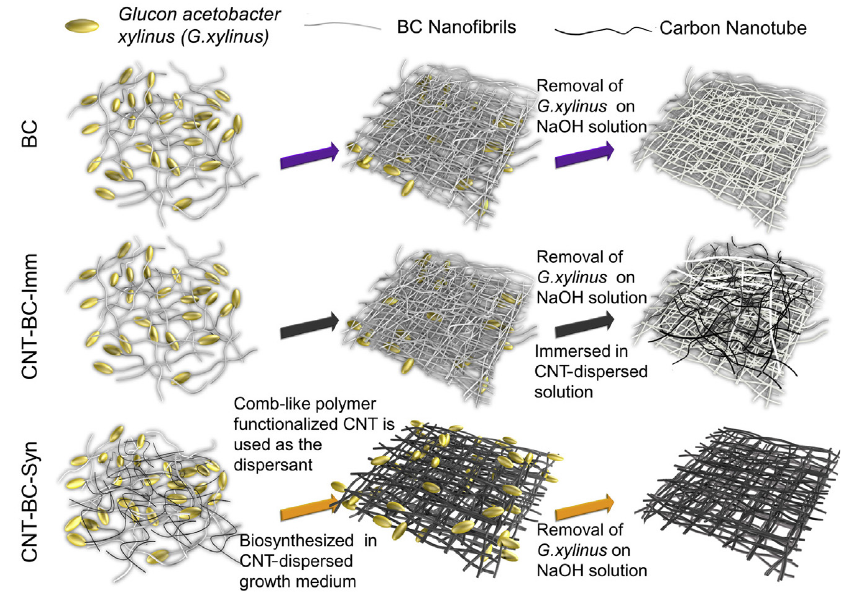
Figure 10. Schematic illustration of the 3D scaffold fabrication processes of BC, CNTs-BC-Imm, and CNTs-BC-Syn. Adapted with permission from the authors of [145]. Copyright 2015 Elsevier. CNTs-BC-Syn. Adapted with permission from [145]. Elsevier,